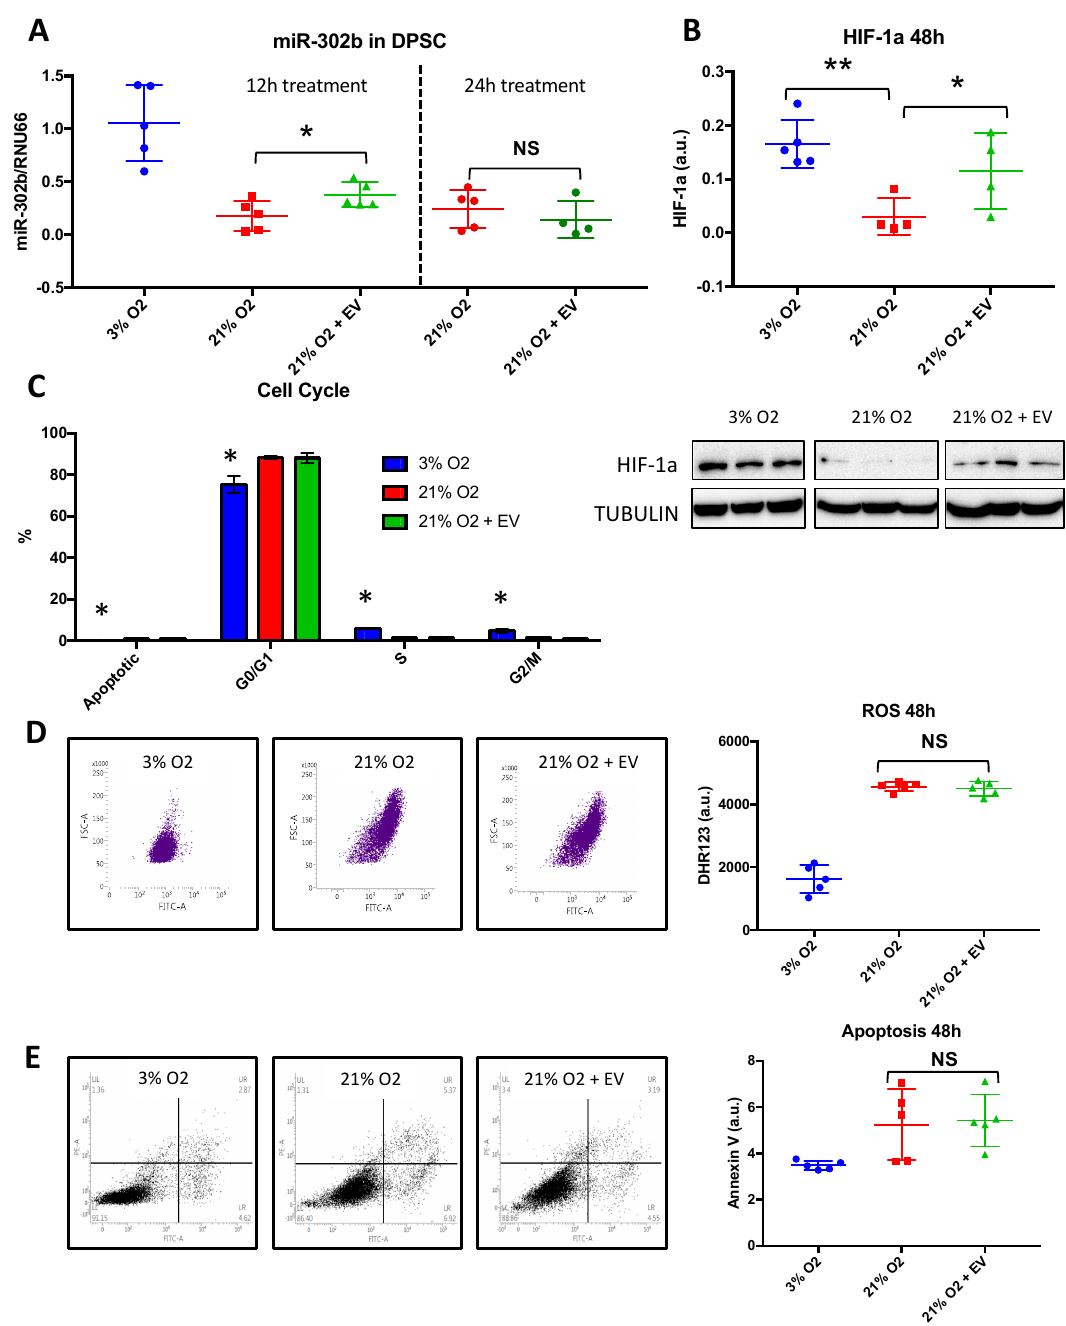
Figure 5. EVs increase miR-302b and HIF-1 α expression in premature senescent cells, independently of ROS or apoptosis. ( A ) miR-302b relative expression levels in DPSC at either 12 h or 24 h post-treatment, ( B ) HIF-1 α protein levels, ( C ) cell cycle in hDPSCs cultured at 3% O 2 and hDPSCs, cultured at 21% O 2 with or without EV treatment. ( D ) ROS levels and ( E ) apoptosis 48 h post-treatment. The data are shown as means ± SD ( n = 5). Statistical significance is expressed as * p < 0.05; ** p < 0.01. NS means no significance.